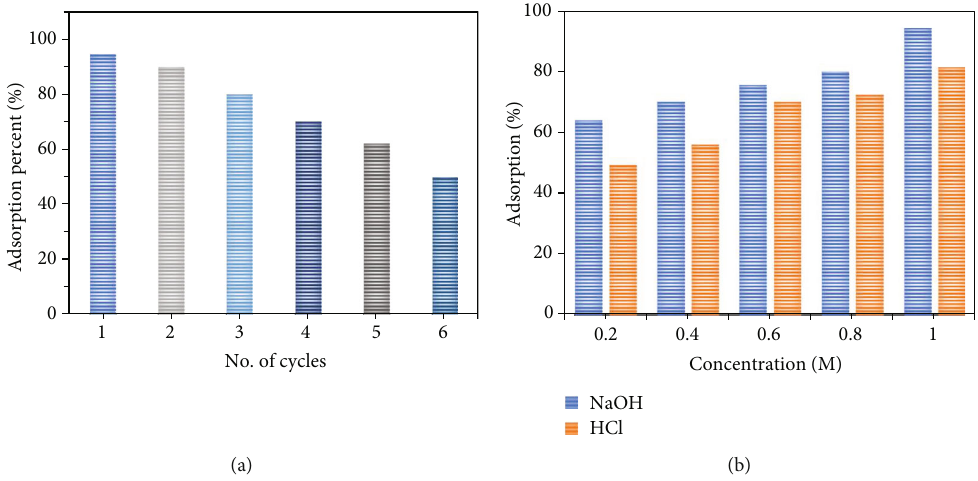
Figure 24: (a) Adsorption-regeneration cycle. (b) Regeneration of ACMAS with NaOH and HCl. Table 12: ACMAS recycle-regeneration data using 1.0M NaOH.